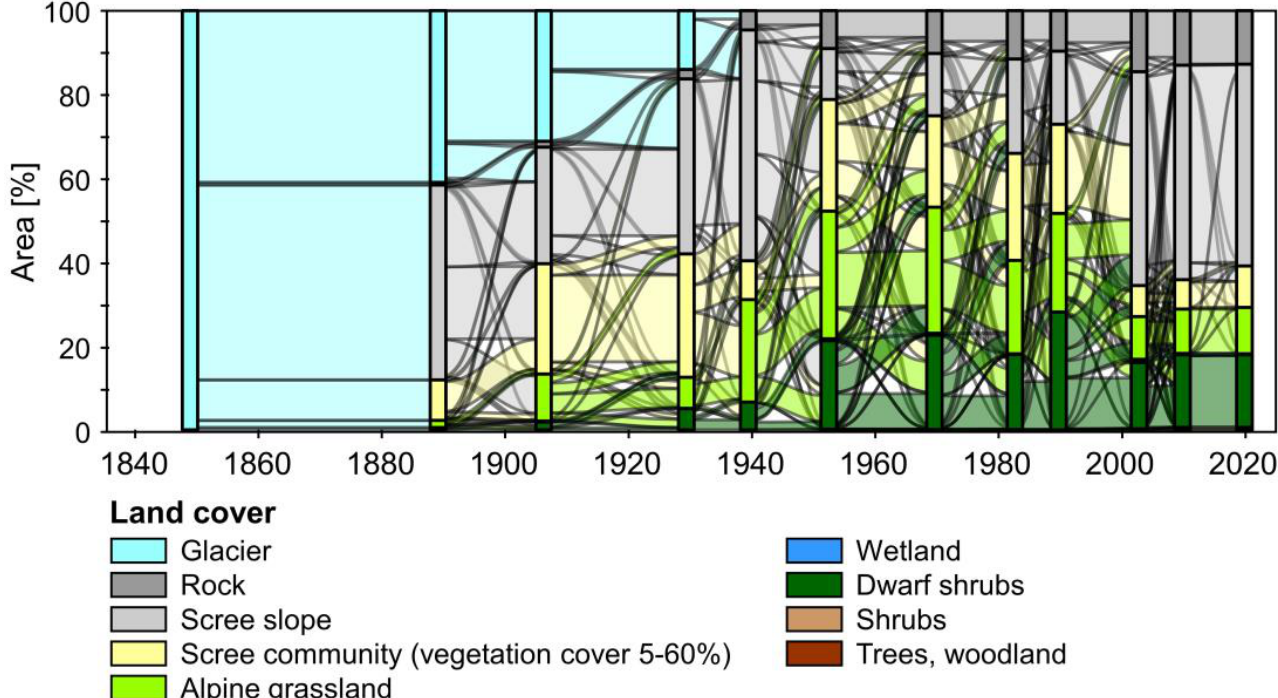
Figure 8. Development of land-cover types from the end of the Little Ice Age to 2020.